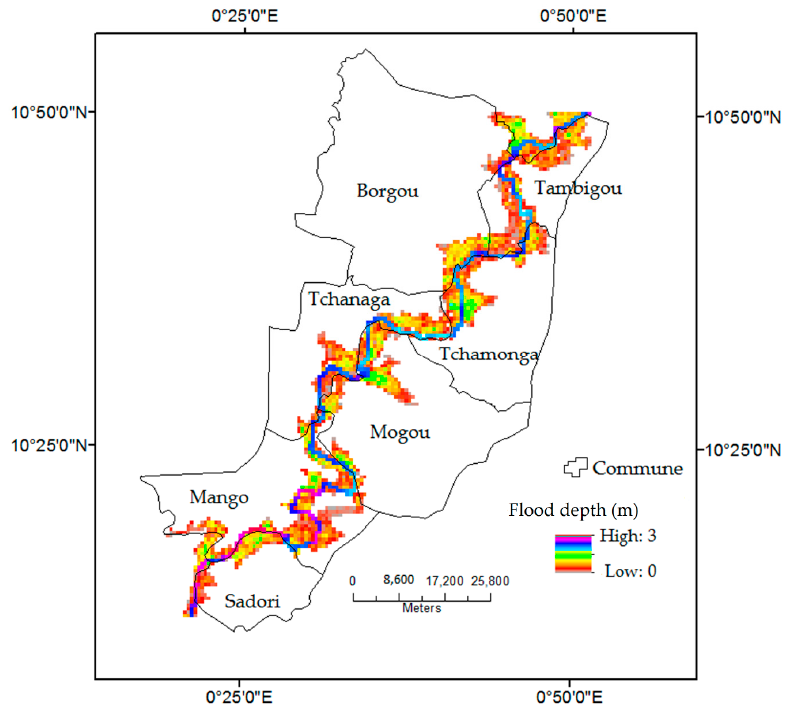
Figure 2. Simulated 50-year flood map of the Oti River Basin in Togo.